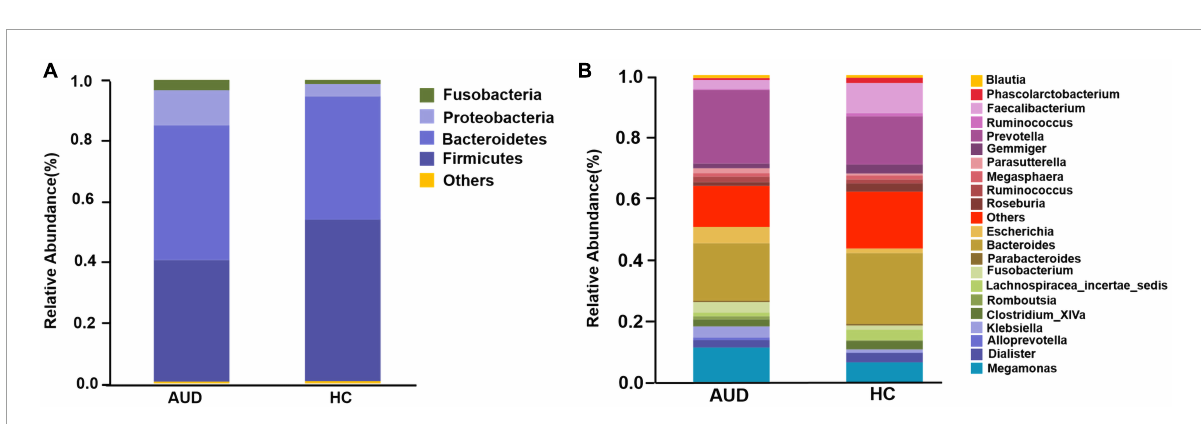
FIGURE2 Comparison of the relative abundance of gut microbiota at different levels between AUD and HC groups. (A) The phylum level and (B) the genus